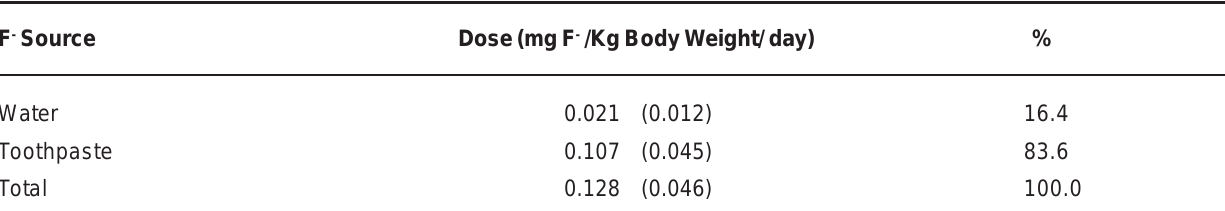
TABLE 2- Mean (±SD) ingested fluoride from water and dentifrice (mg F - /Kg Body Weight/ day) by children living in Penedo, Brazil